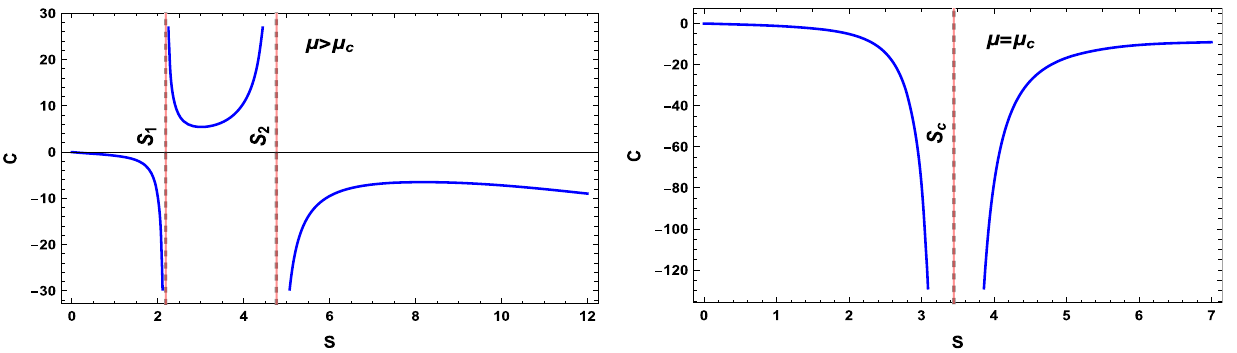
Fig. 7 Grand canonical ensemble: temperature as a function of S (left). The Gibbs free energy versus T for the neutral BH (right). We used the following values: (cid:16) = 0 . 5 , c = 1 , α = 1 and β = 2